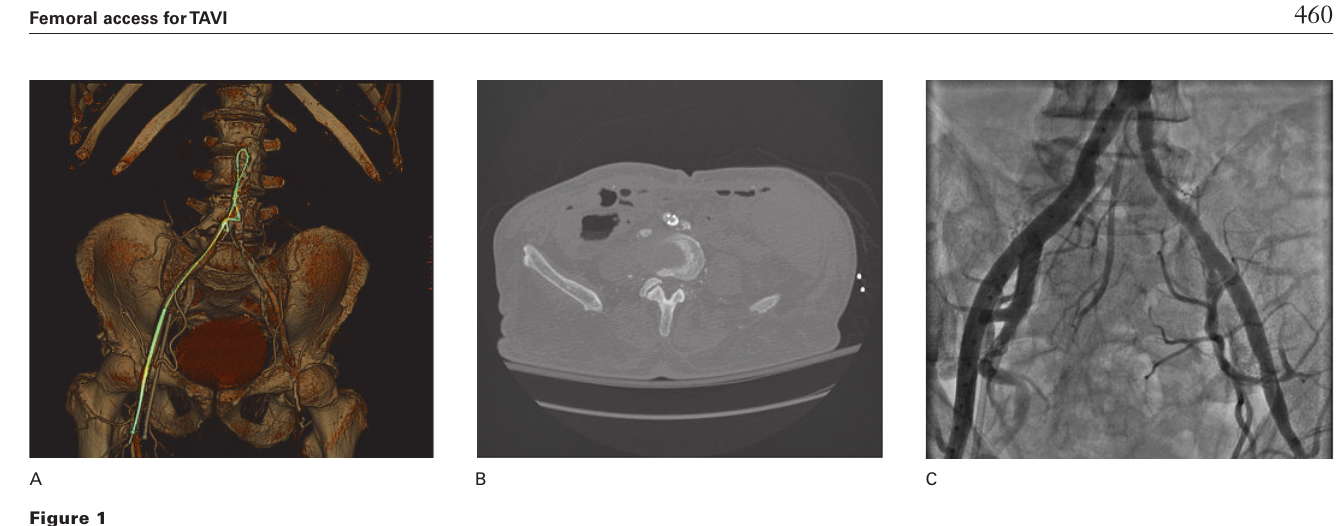
Figure 1 A: Coronal VR image showing the pigtail catheter coiled back in the right common iliac artery. B: Underestimation of luminal diameter in an axial plane in the same patient. C: Angiogram of the femoral arteries in the same patient confirming the overestimation of disease in the left iliofemoral